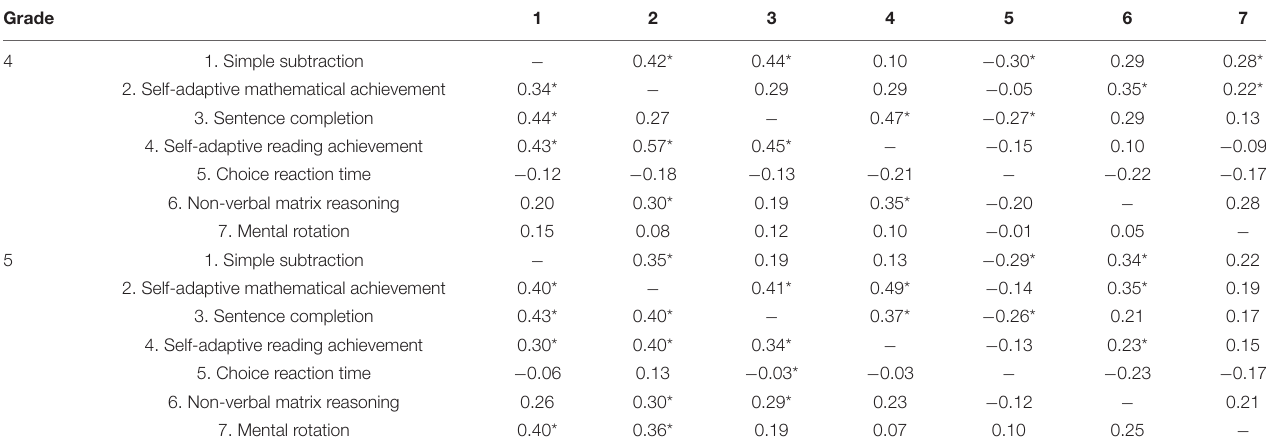
TABLE 2 | Correlations between the measures used in the study for Minority (above the diagonal) and Han (below the diagonal).